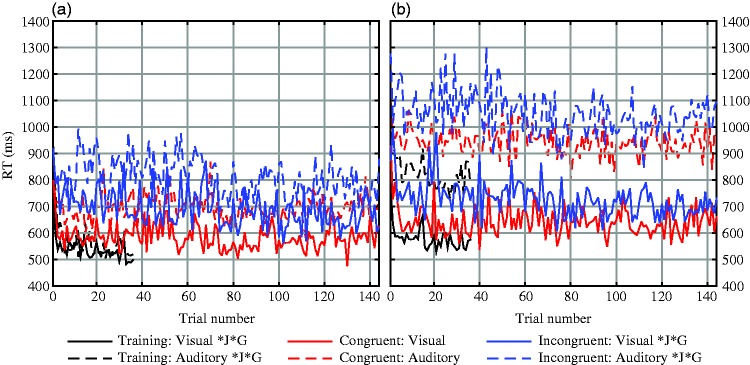
Average RT plotted along the trial number for each condition
and modality for (a) Japanese and (b) German participants.
*J: Estimated linear coefficients were significantly
smaller than zero (p < .05) for
Japanese data; *G: Estimated linear coefficients were
significantly smaller than zero
(p < .05) for German data.RT = response time.